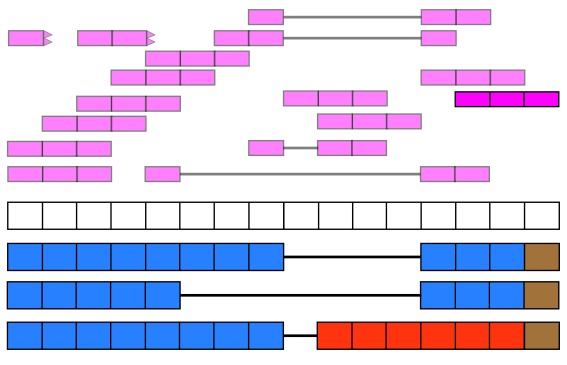
Exon boundaries.Reads that go beyond the known exon boundaries can inform us of whether the annotated boundaries are correct or if there was a run-off transcription event.